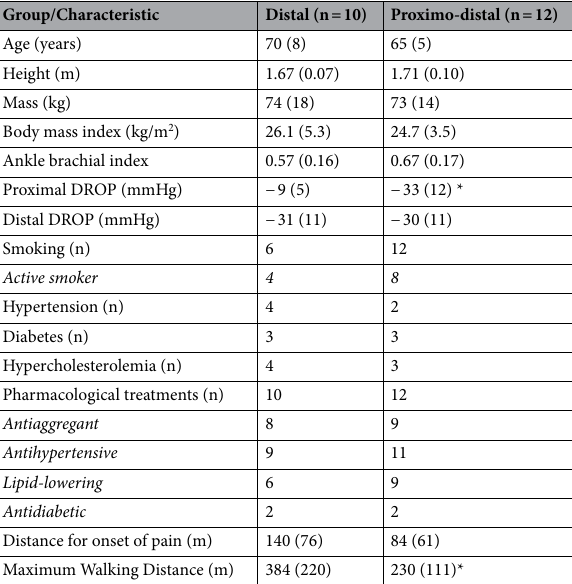
(Table 3): the TA activation peak in the PROXDIS group only (decreasing by 13.0%, Fig. 2, Table 3, P = 0,035), the GM activation peak (decreasing by 2.5% in DIS and 4.5% in PROXDIS, Fig. 2, Table 3) and the GM activa-